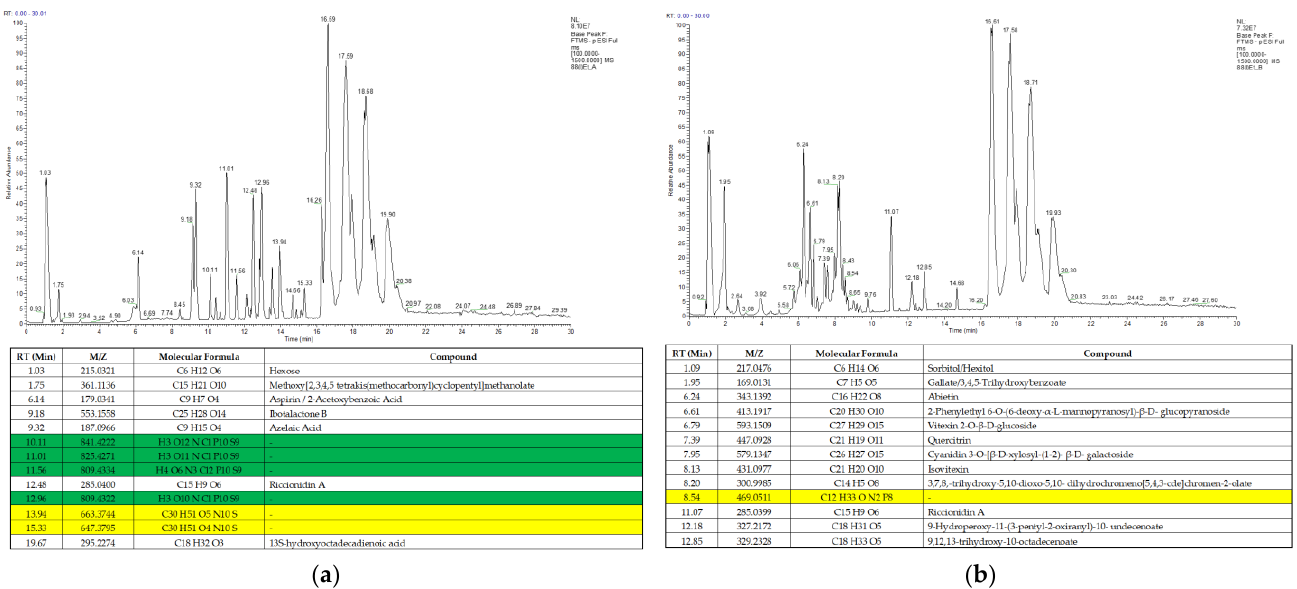
Figure 6. Chromatogram of ethanol-based solvent S. caseolaris leaves extract: ( a ) run A; ( b ) run B. Upper panels are chromatogram of LC-MS/MS data and lower panels are list of identified compounds.